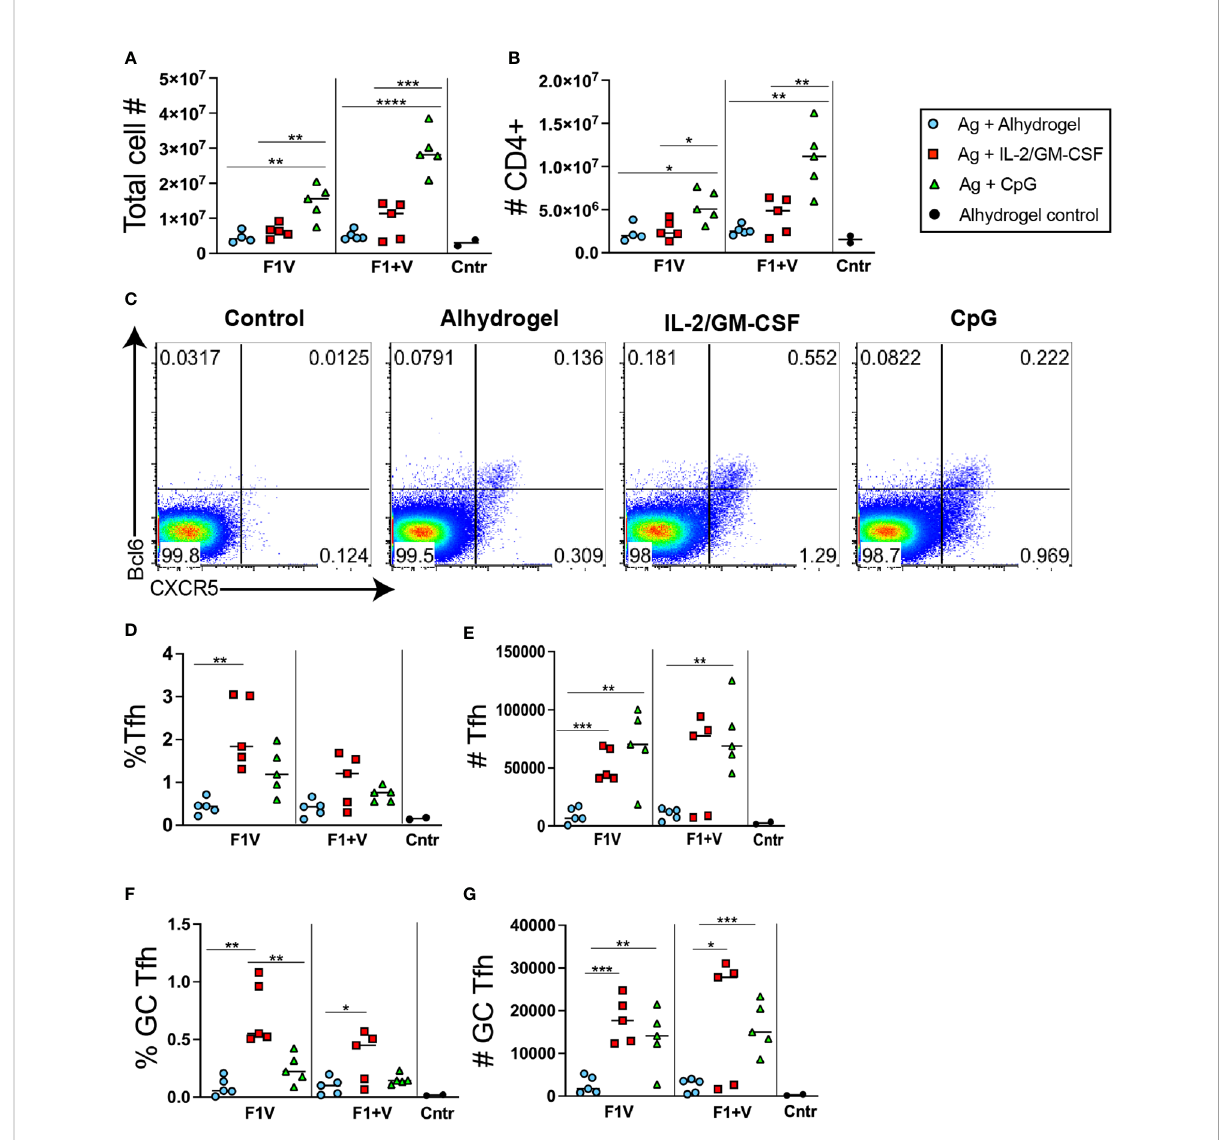
FIGURE 2 T follicular helper cell responses 7 days post-immunization. Analysis of lymphocyte responses in the draining lymph nodes (dLNsj) 7 days post- immunization. (A) Total number of cells in dLNs. (B) Total number of CD4+ T cells in dLNs. (C) Flow cytometry analysis of CXCR5 and Bcl6 expression by CD4+ gated T cells in the dLNs. (D) Frequency and (E) number of Tfh (CXCR5+) cells in the dLNs. (F) Frequency and (G) number of CXCR5+ Bcl6+ GC Tfh in dLNs. n=5 per group per experiment at each time point. Data shown are from one experiment and are representative of two independent experiments. Statistically signi fi cant p values were determined using a two-tailed unpaired Student t test; *p < 0.05, **p < 0.01, ***p < 0.001, ****p < 0.0001